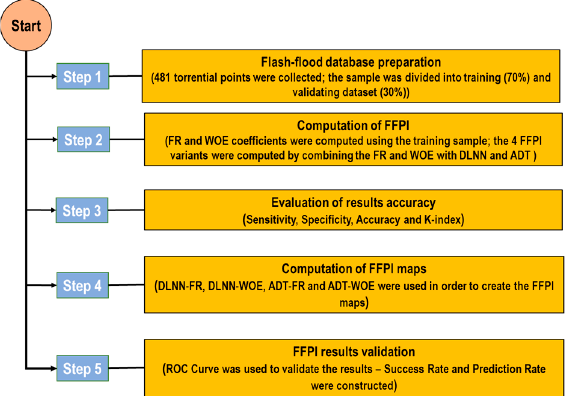
Figure 4. Flowchart of the methodological steps applied in this research.